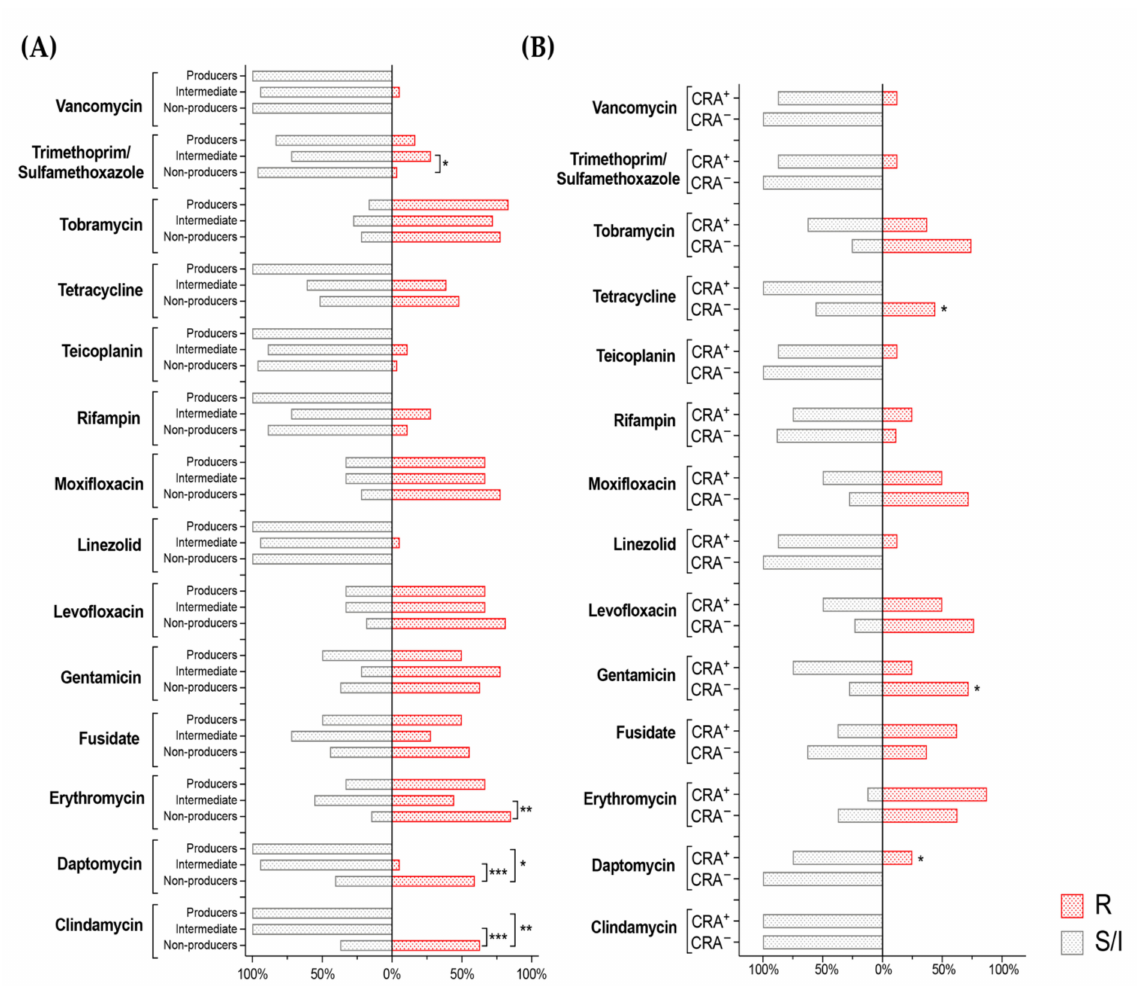
Figure 7. The relationships between antibiotic susceptibility, biofilm formation, and PIA expression among the S. epidermidis clinical isolates. ( A ) Prevalence of antibiotic resistance among the biofilm- producer, intermediate-producer, or non-producer clinical S. epidermidis strains. ( B ) Prevalence of antibiotic resistance among the CRA-positive (CRA + ) and CRA-negative (CRA − ) clinical S. epidermidis strains. Statistical significance analyzed with Fisher’s exact test for each condition was reported (* p < 0.05, ** p < 0.01, *** p < 0.001). R = Resistant (in red), S/I = Susceptible or increased exposure (in